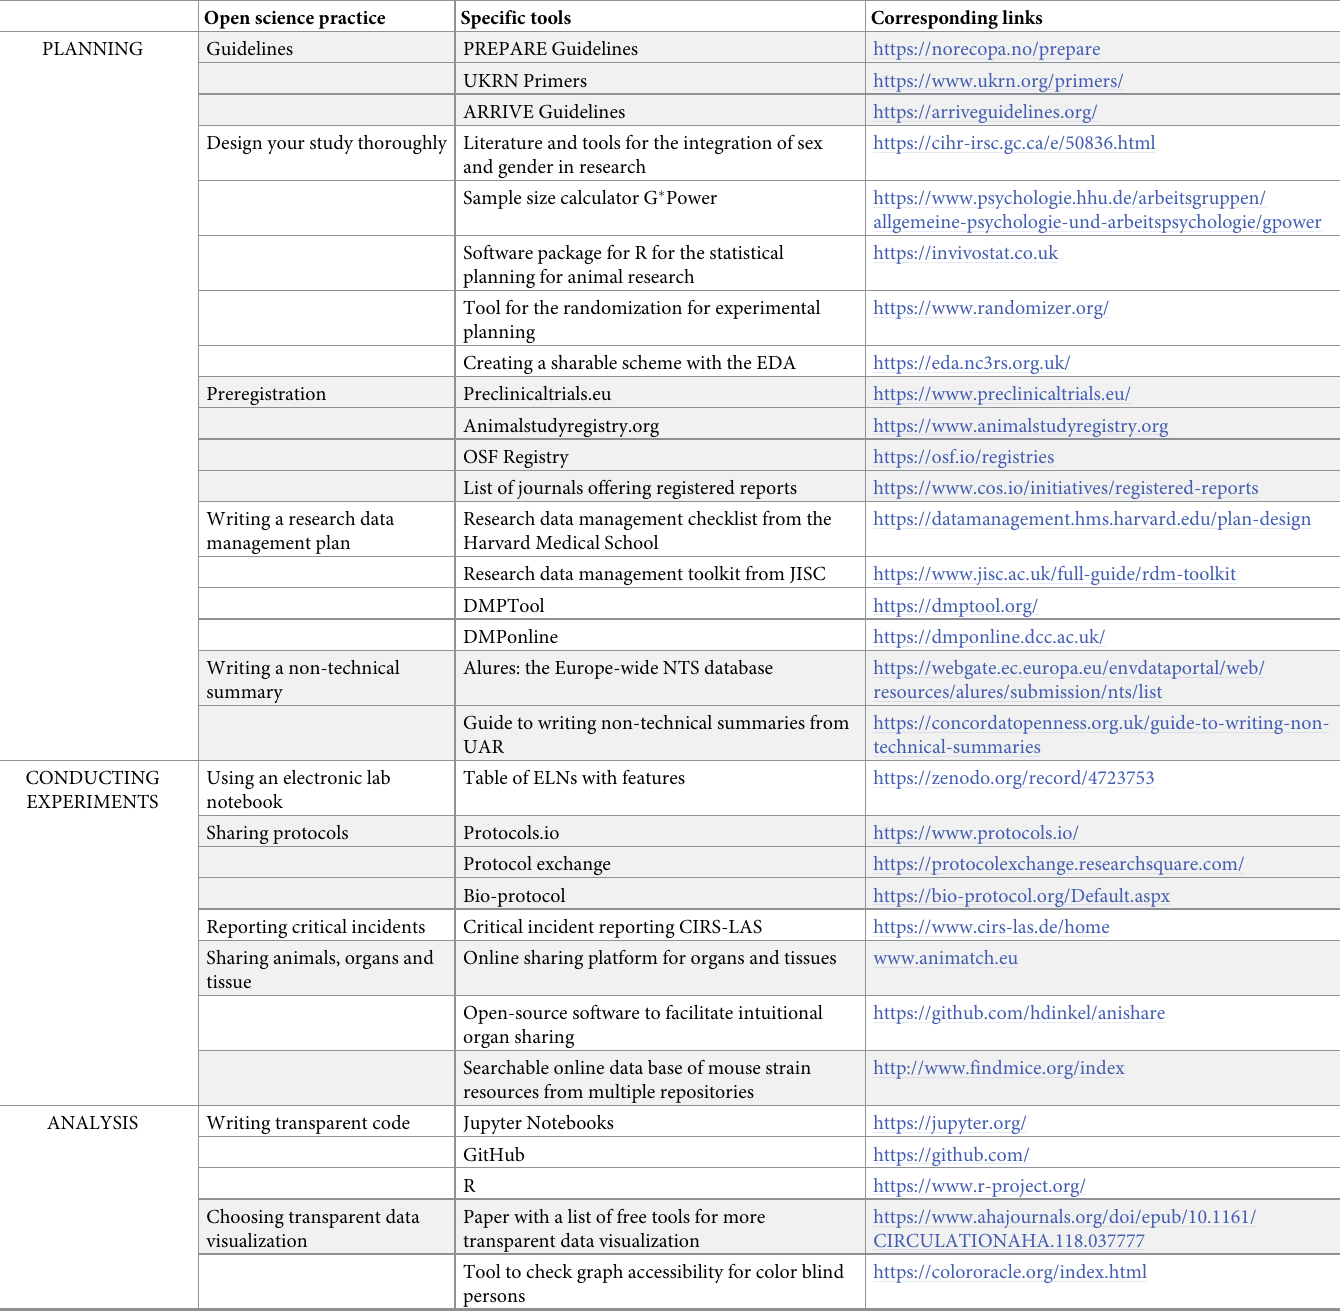
Table 1. Open science toolbox for translational biomedical